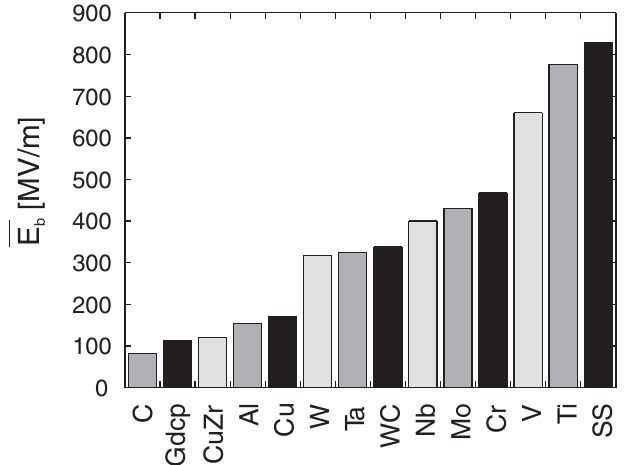
FIG. 5. Average breakdown field after conditioning of the main materials tested.